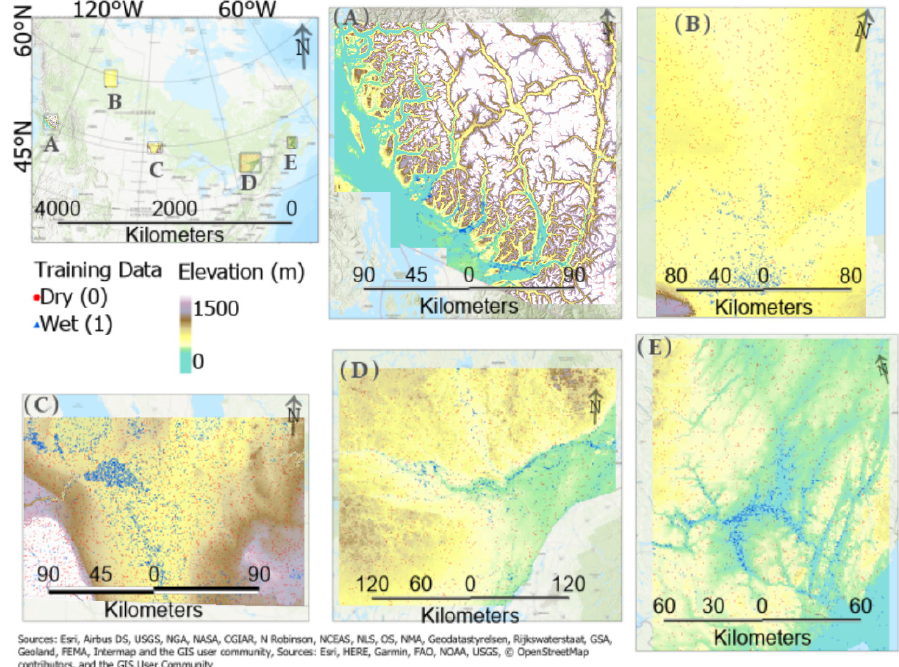
Figure 2. Top-left, overview of study areas the digital terrain model and the training points, ( A ) British Columbia study (BC), ( B ) Alberta/Northwest Territories (AB) study area, ( C ) Manitoba (MB), ( D ) Na- tional Capital Region (NCR) and ( E ) New Brunswick